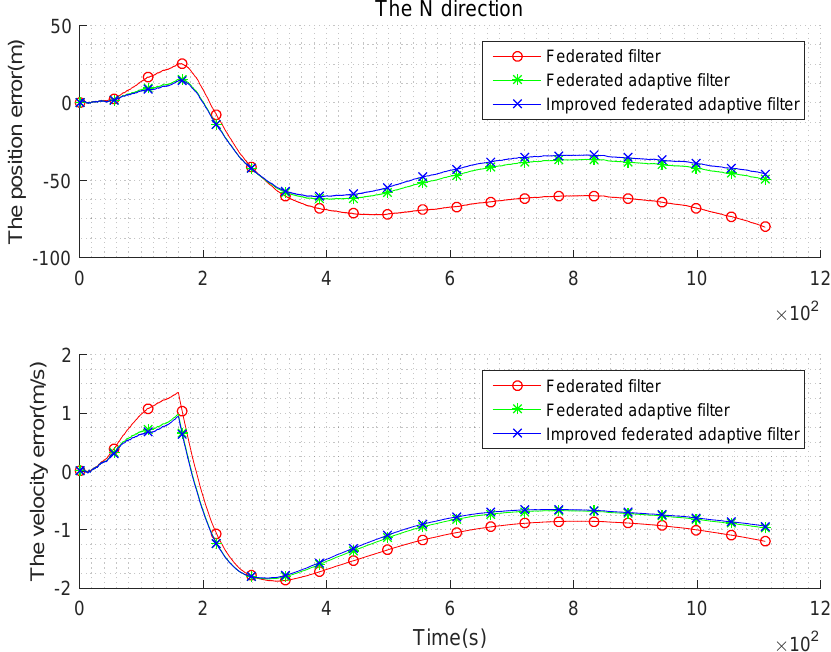
Figure 8. Comparison of the navigation error with Gaussian state noise and biased estimation in N